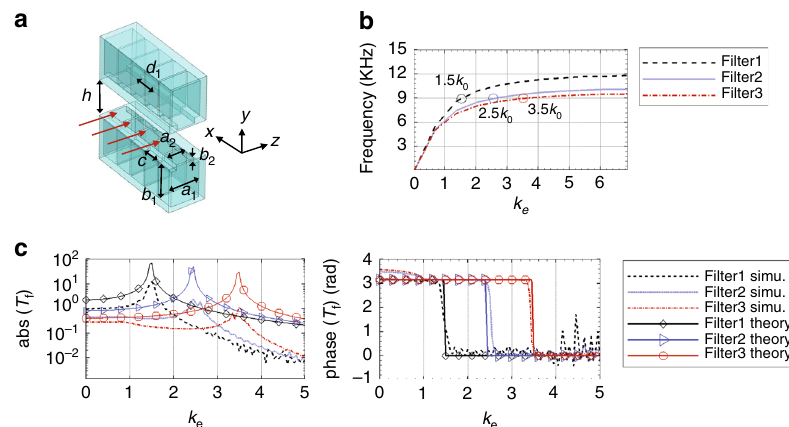
Fig. 2 Model and properties of the fi lter layer. a Model for fi lter layer. The geometric parameters are: b 1 = 5 mm, a 2 = 2.5 mm, c = 2.5 mm, b 2 = 0.75 mm, h = 5 mm, and d = 2.75 mm. By changing a fi ltered wave vector can be tuned. We choose a 1 1 , the ( fi lter2), and a 1 = 6.5 mm for k e = 3.5 ( fi lter3). b Theoretically calculated dispersion relations of fi lter1, fi lter2 and fi lter3 in the x direction. The dispersion relation curves of fi lter1, fi lter2 and fi lter3 pass through k e = 1.5, k e = 2.5 and k e = 3.5, respectively at f 0 = 9000 Hz. c Amplitudes and phases of theoretically calculated and simulated transmission coef fi cients of fi lter